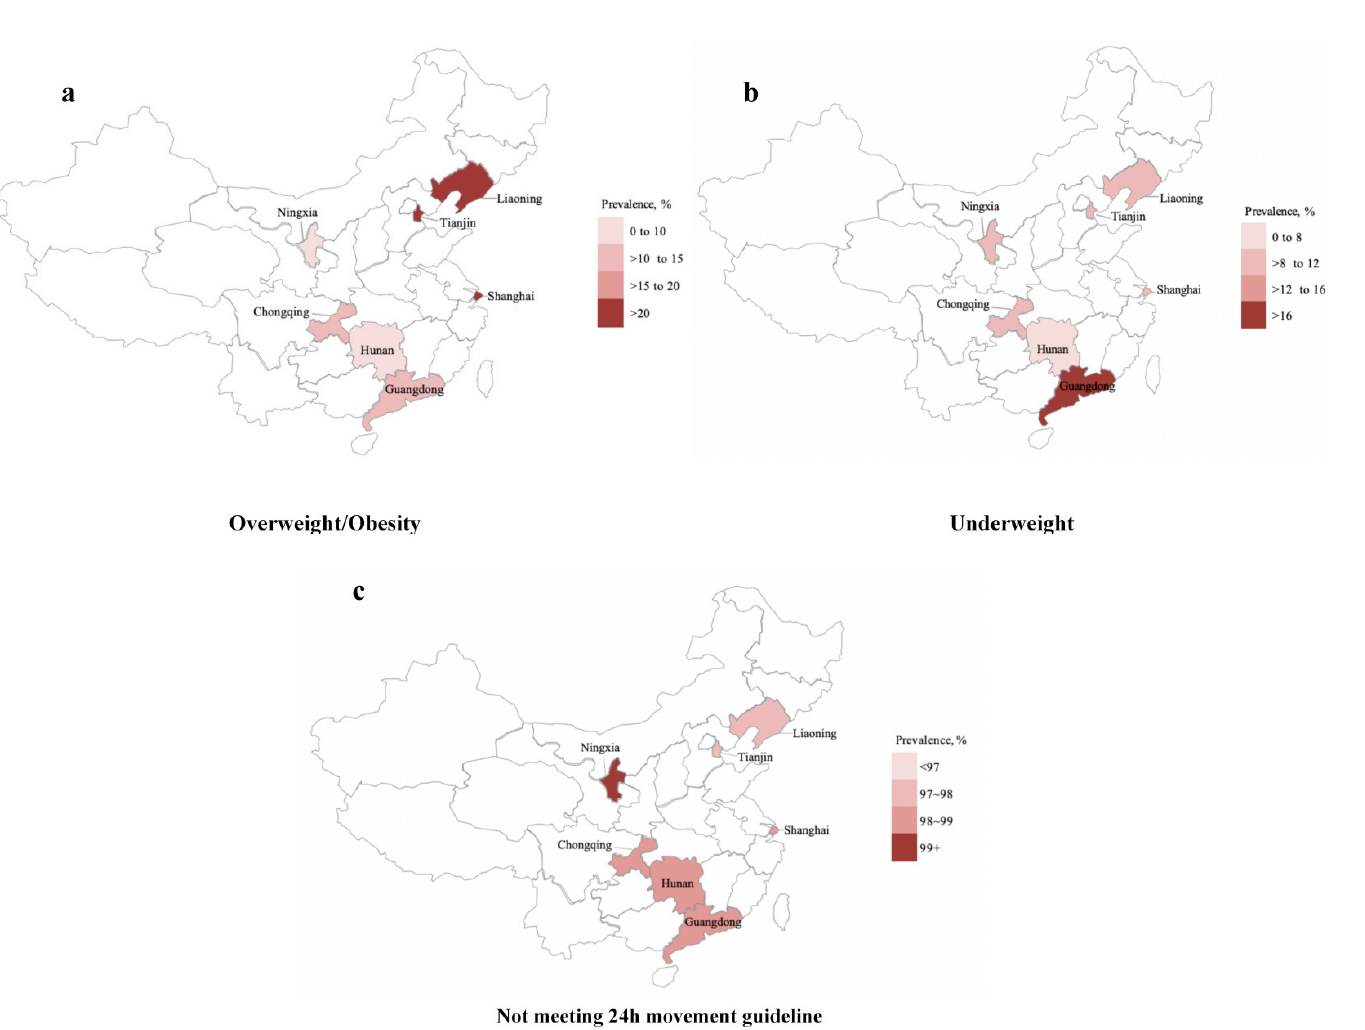
Figure 2. Prevalence of underweight, overweight or obesity and meeting the 24 h movement guidelines among school-aged children and adolescents in mainland of China ( a ) presents the prevalence of overweight/obesity, ( b ) presents underweight and ( c ) presents not meeting 24 h movement guidelines.